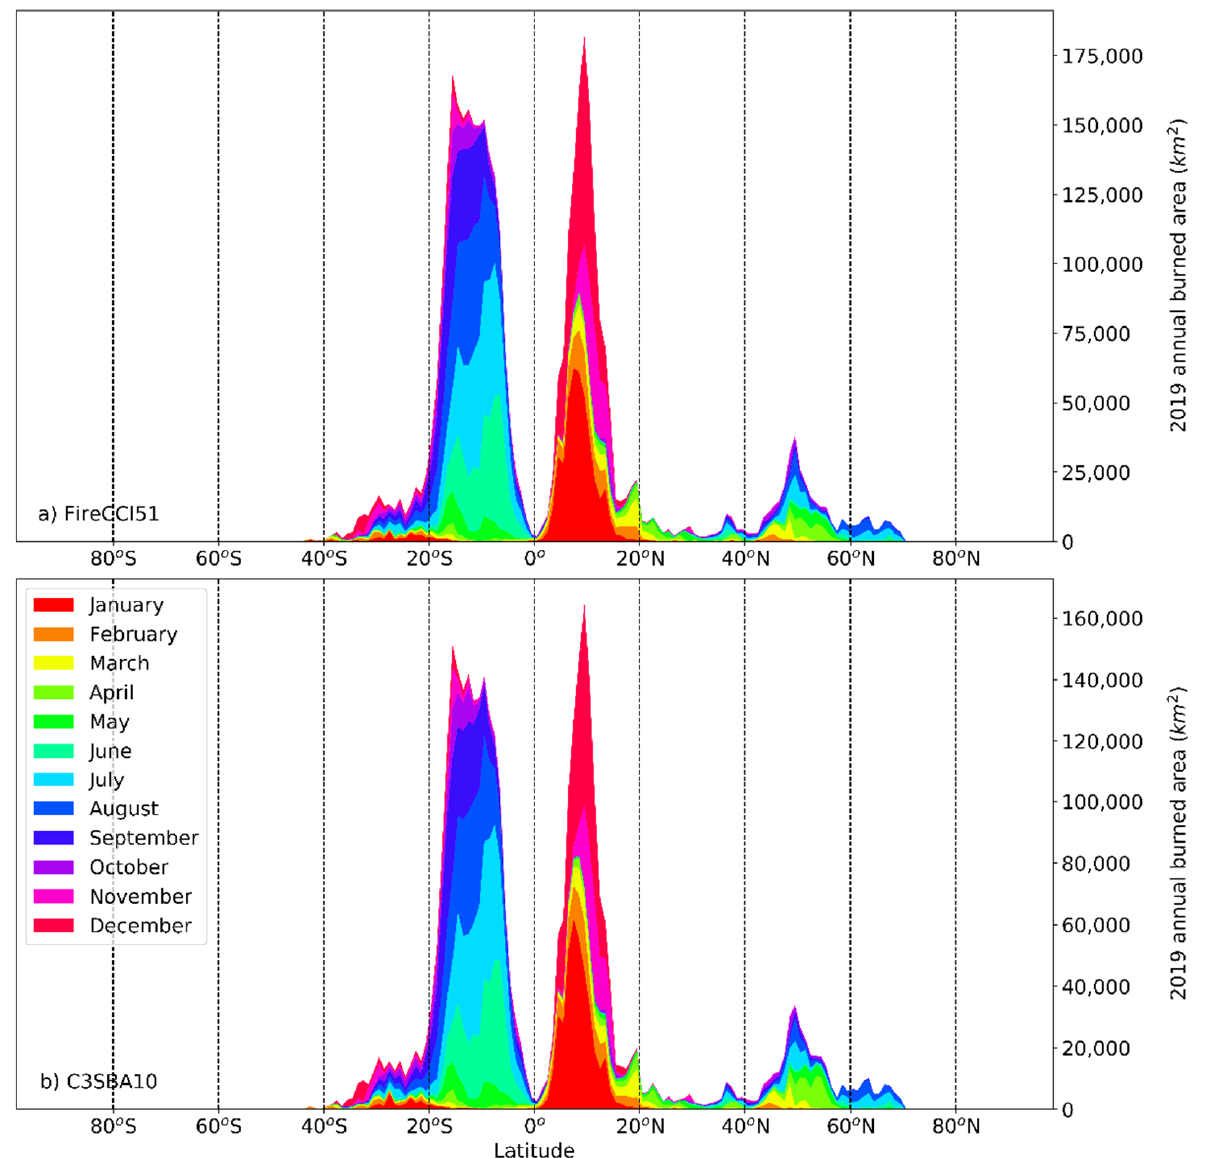
Figure 6. Monthly burned area for 2019 distributed along latitudes determined by FireCCI51 ( a ) and C3SBA10 ( b ). Table 4. Global correlation coefficient between FireCCI51 and C3SBA10, slope and RMSE for